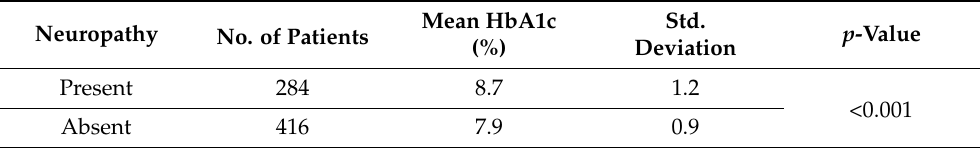
Table 8. Relationship between HbA1c level and clinical